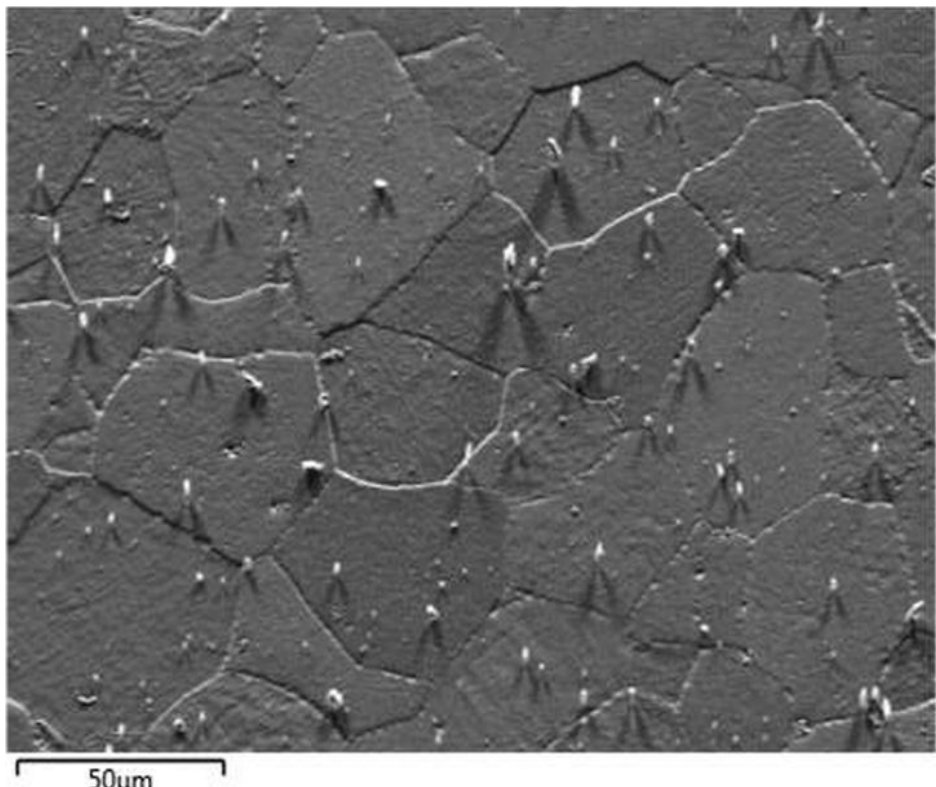
Figure 6. FSD mixed image of sputtered area of steel 1.4521 (AISI 444).